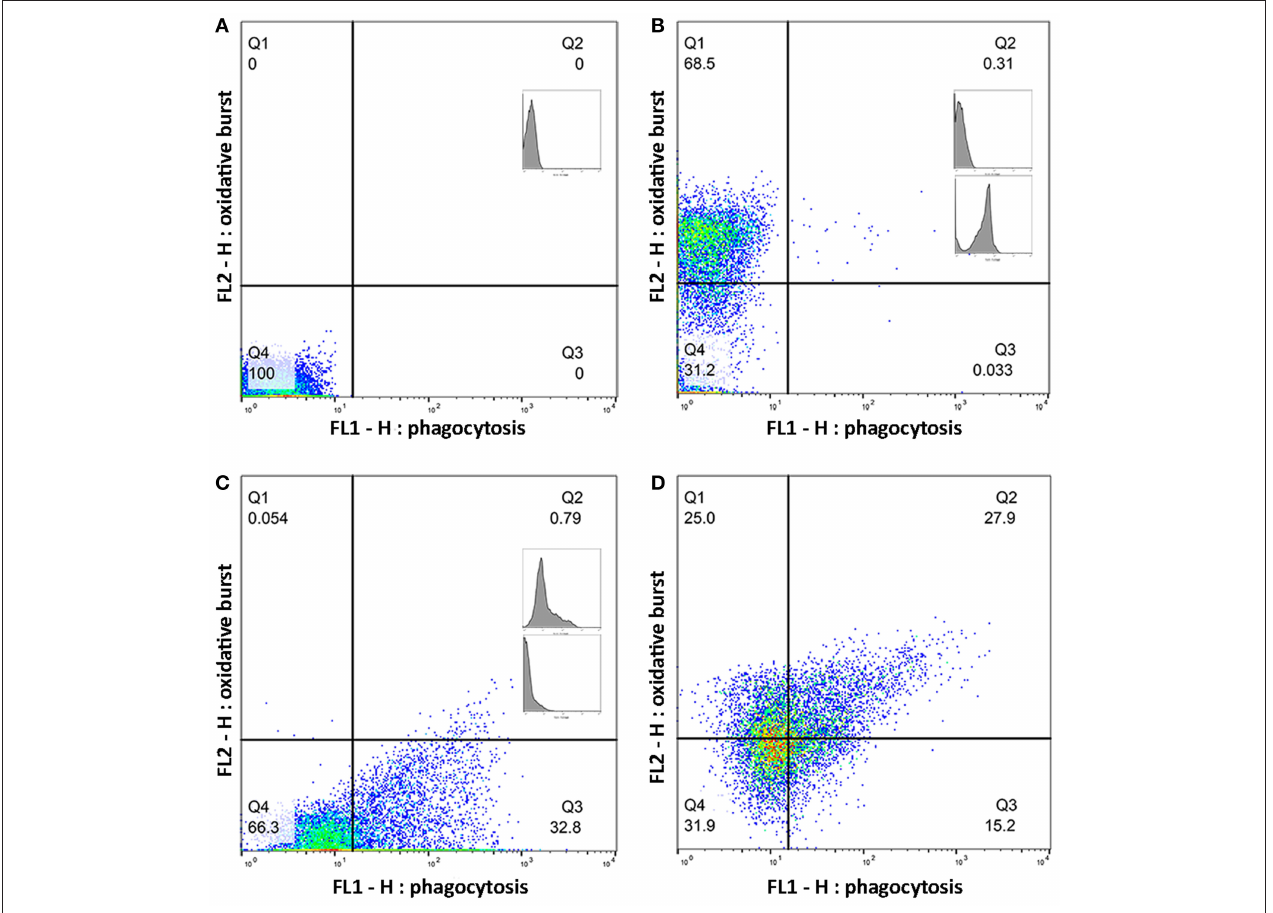
FIGURE 2 | Quadrants for single and double positive cells were established using a set of control samples. Plots (A–D) show a representative sample of gated monocytes from one sample. The number in each quadrant is the percentage of cells. (A) Monocytes without a flurochrome added. (B) Monocytes with only dihydrorhodamine (DHR) 123 added. (C) Monocytes with only pHrodo TM Red S . aureus added. (D) Monocytes with both DHR and pHrodo TM Red S. aureus added.